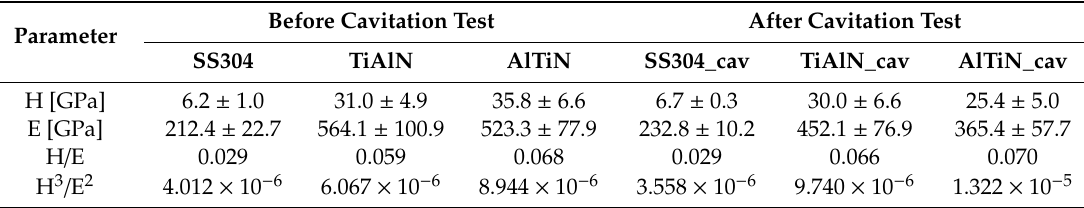
Figure 9. Loading ‐ unloading nanoindentation curves estimated on the films and reference SS304 surface, before and after (marked as “cav”) cavitation erosion tests. Table 3. Results of hardness (H) and elastic modulus (E) measured on the surface of samples before and after (marked as “cav”) cavitation tests.